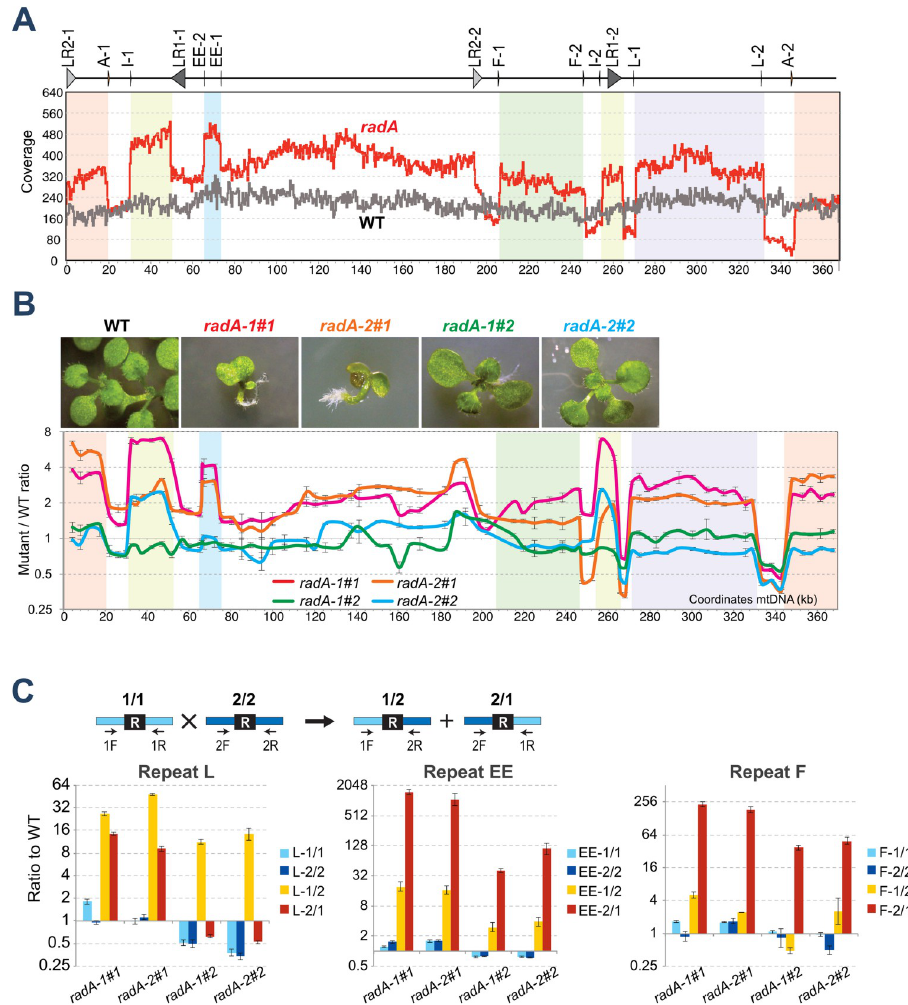
Fig 6. Changes in mtDNA sequences stoichiometry in radA mutants because of increased recombination across intermediate size repeats. ( A ) Comparison of Illumina sequence coverage of the mtDNA in radA-1 as compared to WT. Coordinates are those of the Col-0 mtDNA sequence. The position of the mtDNA large repeats LR1 and LR2 and of relevant IRs are shown above. Regions with changed stoichiometry that are flanked by repeat pairs are shadowed. ( B ) Picture of severely affected ( radA-1 #1 and radA-2 #1) and mildly affected ( radA-1 #2 and radA-2 #2) seedlings and scanning of their mtDNA for changes in relative copy numbers of the different mtDNA regions. Sequences spaced 5–10 kb apart on the mtDNA were quantified by qPCR. Regions with changed stoichiometry flanked by repeat pairs are shadowed as in A. ( C ) Accumulation of recombination products across repeats L, F or EE in radA seedlings. The scheme above shows the qPCR relative quantification of parental sequences 1/1 and 2/2 and of the corresponding alternative arrangements 1/2 and 2/1. Results are in a log2 scale and error bars correspond to SD values from three technical